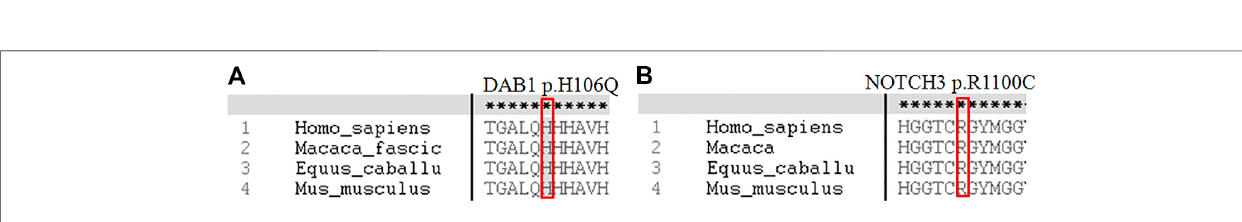
Frontiers in Molecular Biosciences |